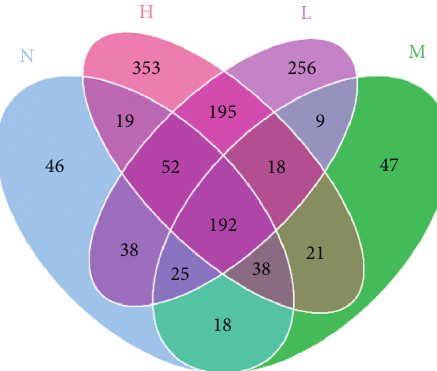
Figure 9: Venn diagram of each group.